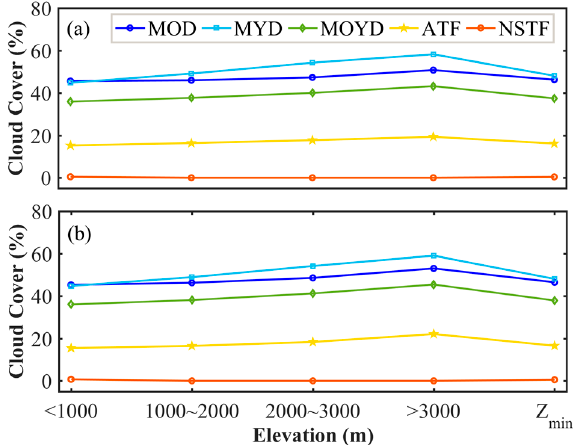
Figure 7. Mean cloud coverage remaining in different elevation zones after the execution of each gap-filling step. ( a ) 2004 and ( b ) the average of 16 years. MOD: MOD10A1; MYD: MYD10A1; MOYD: daily combinated MOD and MYD product; ATF: adjacent temporal filtering; NSTF: non-local spatio-temporal filter.